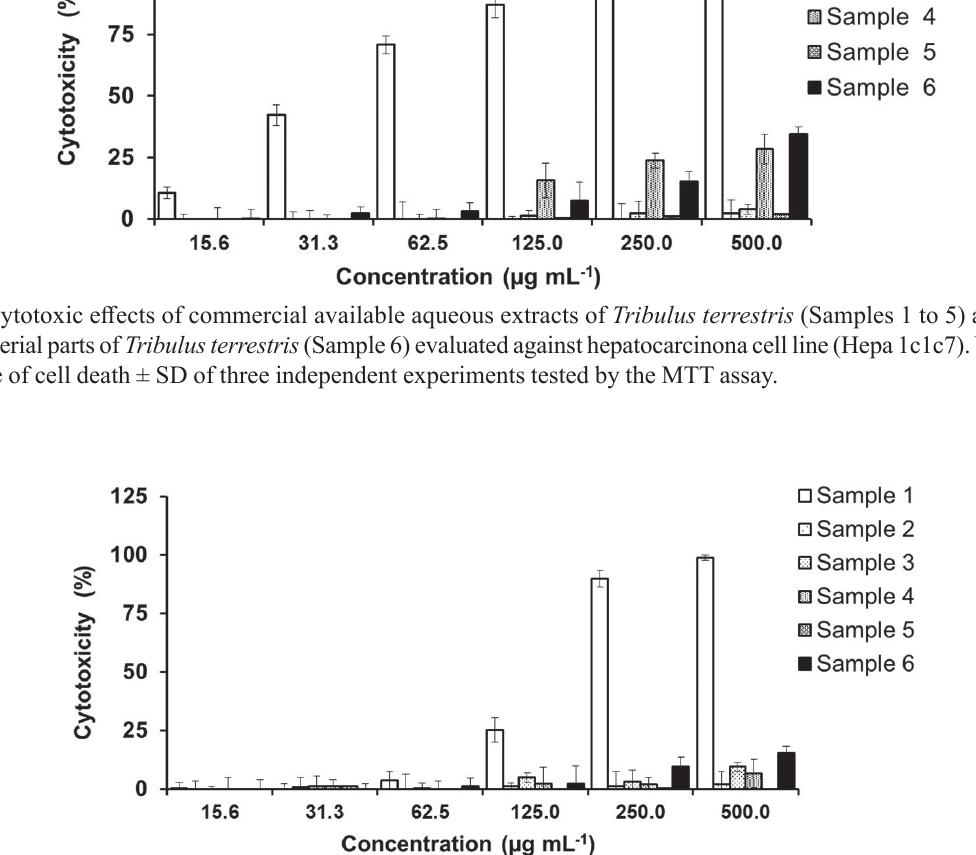
FIGURE 4 - Cytotoxic e ffects of commercially available aqueous extracts of Tribulus terrestris (Samples 1 to 5) and aqueous extract of the aerial parts of Tribulus terrestris (Sample 6) evaluated against the ovarium carcinoma cell line (Ovcar 3). Values represent the percentage of cell death ± SD of three independent experiments tested by the MTT assay.